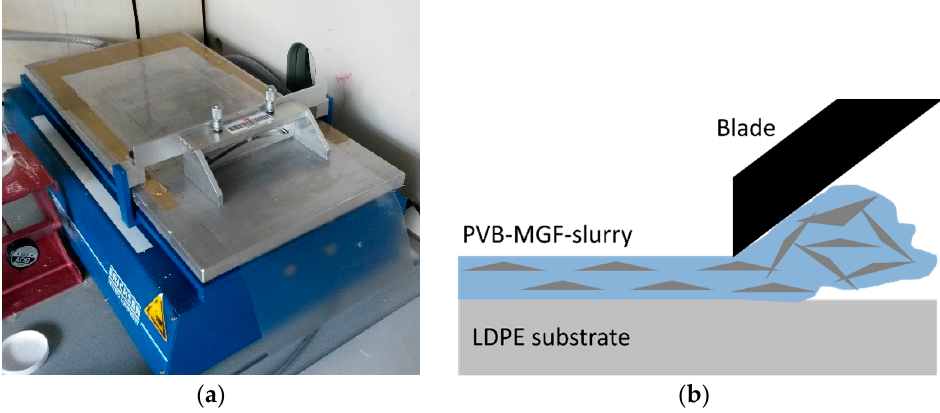
Figure 6. Blade casting setup ( a ) and schematics of the blade casting process with MGF ( b